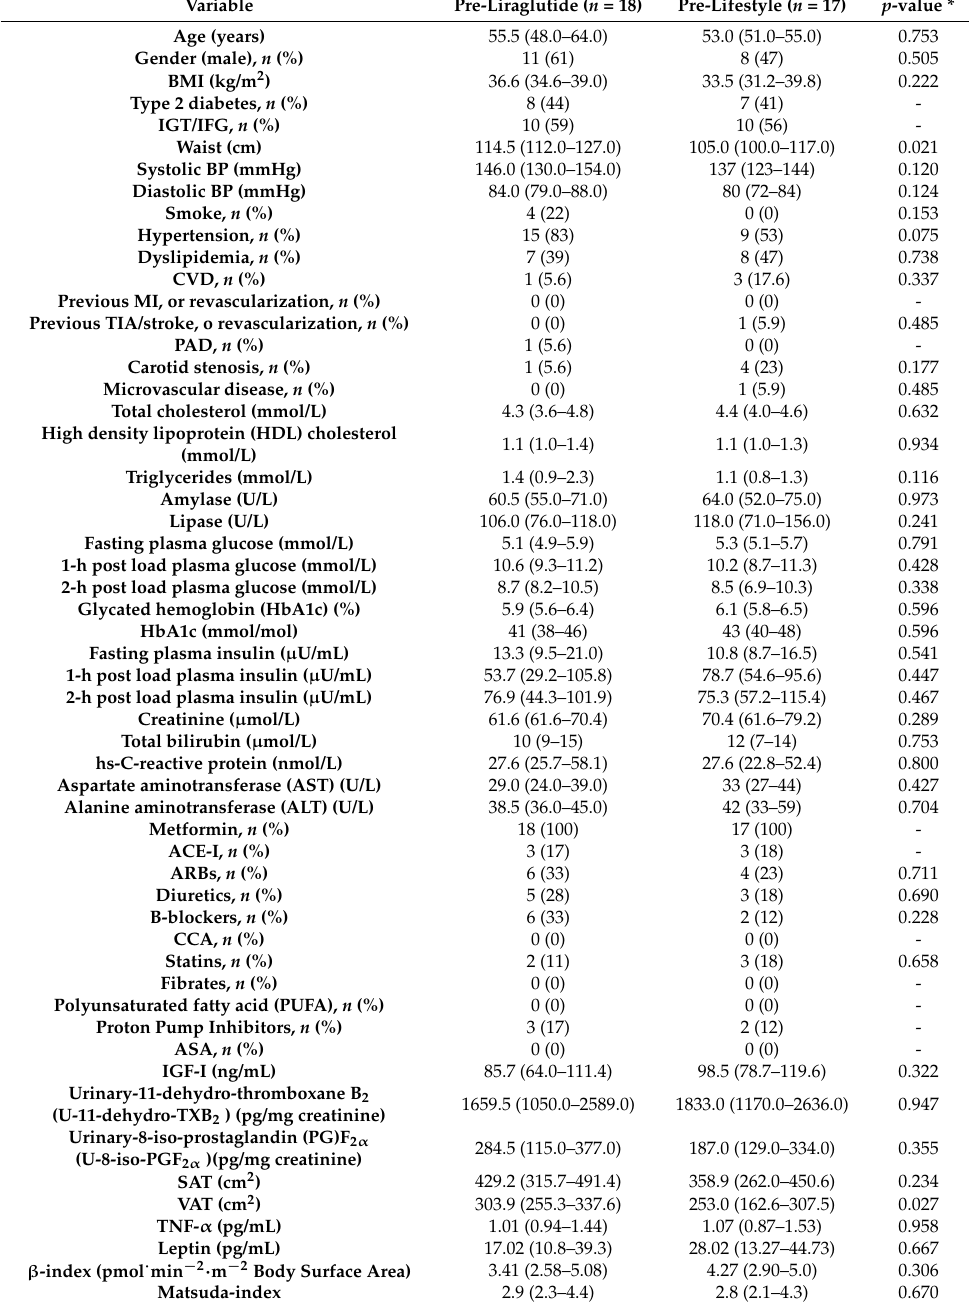
Table 1. Clinical and laboratory baseline characteristics of obese patients randomized to Liraglutide- or lifestyle-induced weight-loss